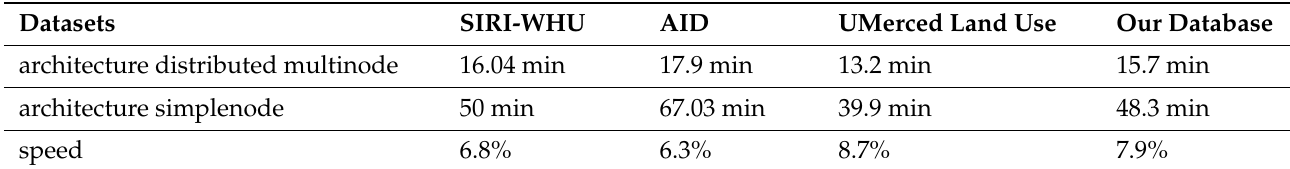
Table 3. Speed measurement of the two architectures.